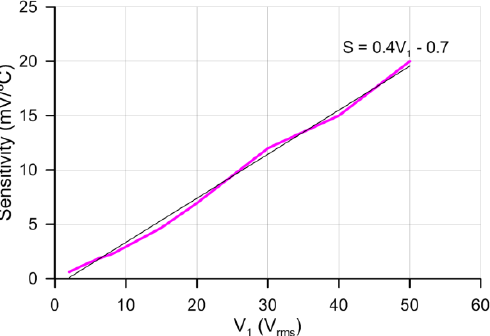
) and linear fit. 1